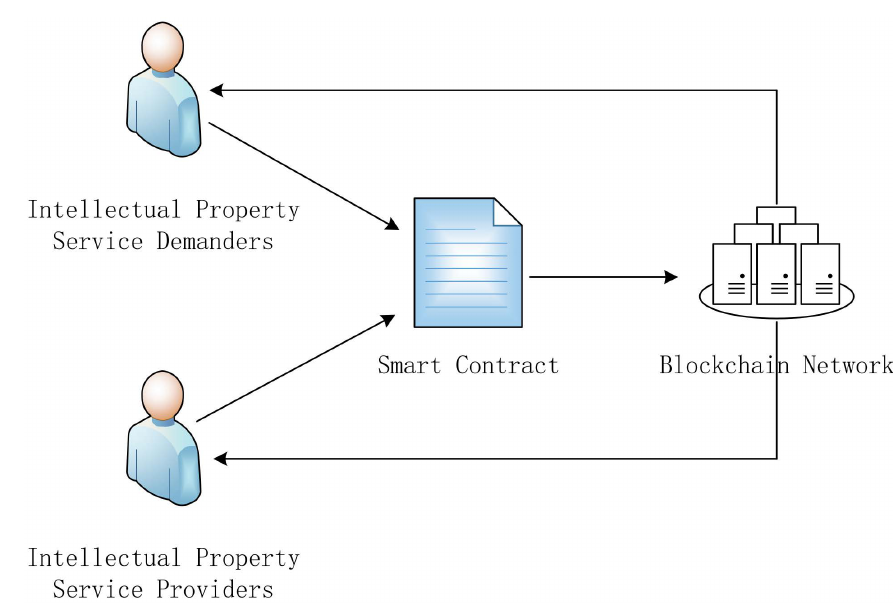
Figure 1. ST-PBFT algorithm’s general architecture.